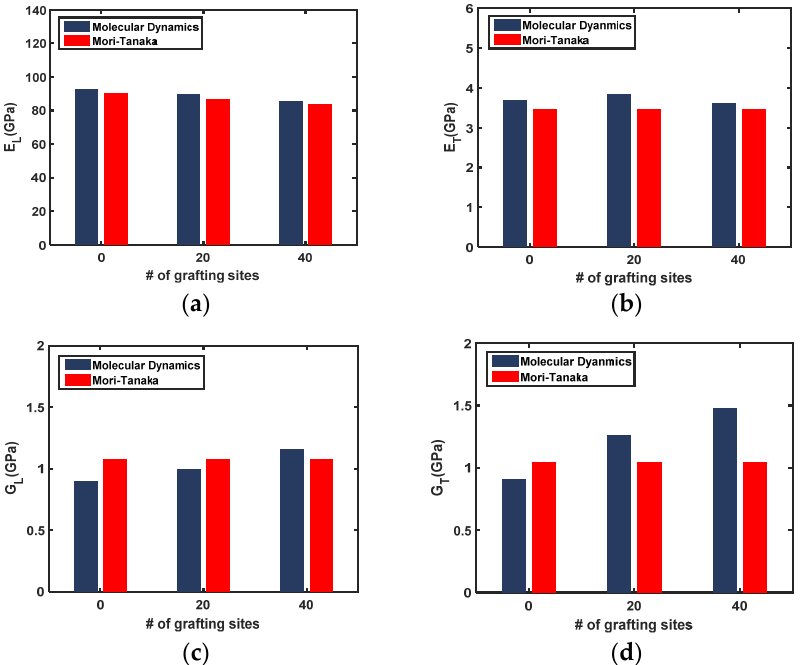
Figure 7. Transversely isotropic elastic modulus of MWNT/PET nanocomposites determined from the MD simulations and the M-T model: ( a ) longitudinal Young’s modulus, ( b ) transverse Young’s modulus, ( c ) longitudinal shear modulus, ( d ) in-plane shear modulus.